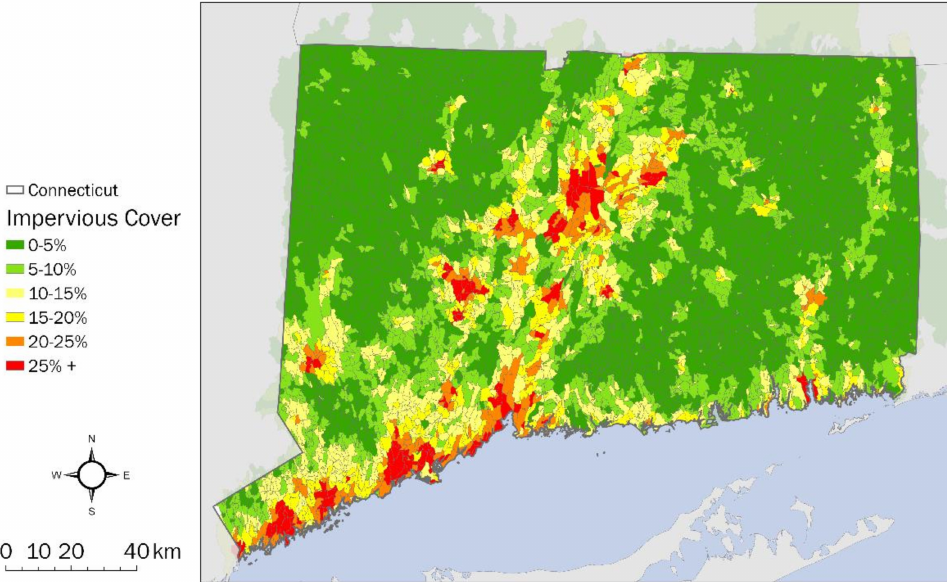
Figure 18. Impervious cover estimates for small watersheds based on 2015 land cover.